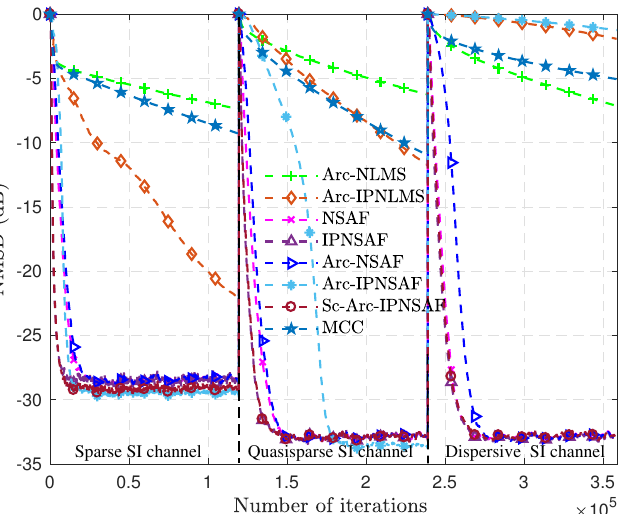
Figure 5. NMSD of different algorithms in sparse, quasisparse, and dispersive SI channels, and the input signal is the AR(2)